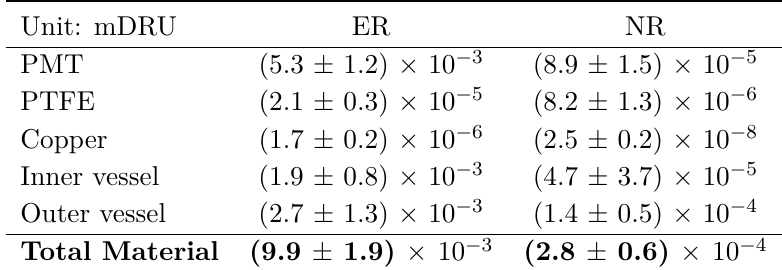
Table 10. Material background contribution in PandaX-4T detector (unit: